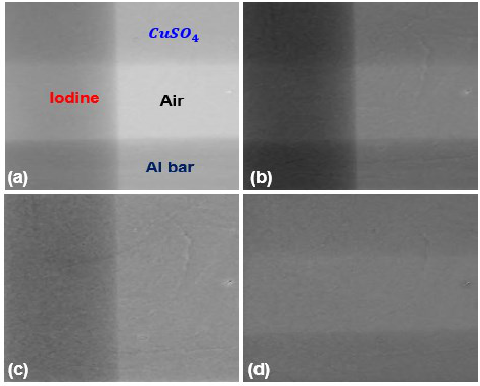
Figure 9. Spectral images. ( a ) A low band image between 24.9–33.27 keV. ( b ) A high band image between 33.27–42.2 keV. ( c ) An iodine image. ( d ) An image of CuSO 4 and aluminum.